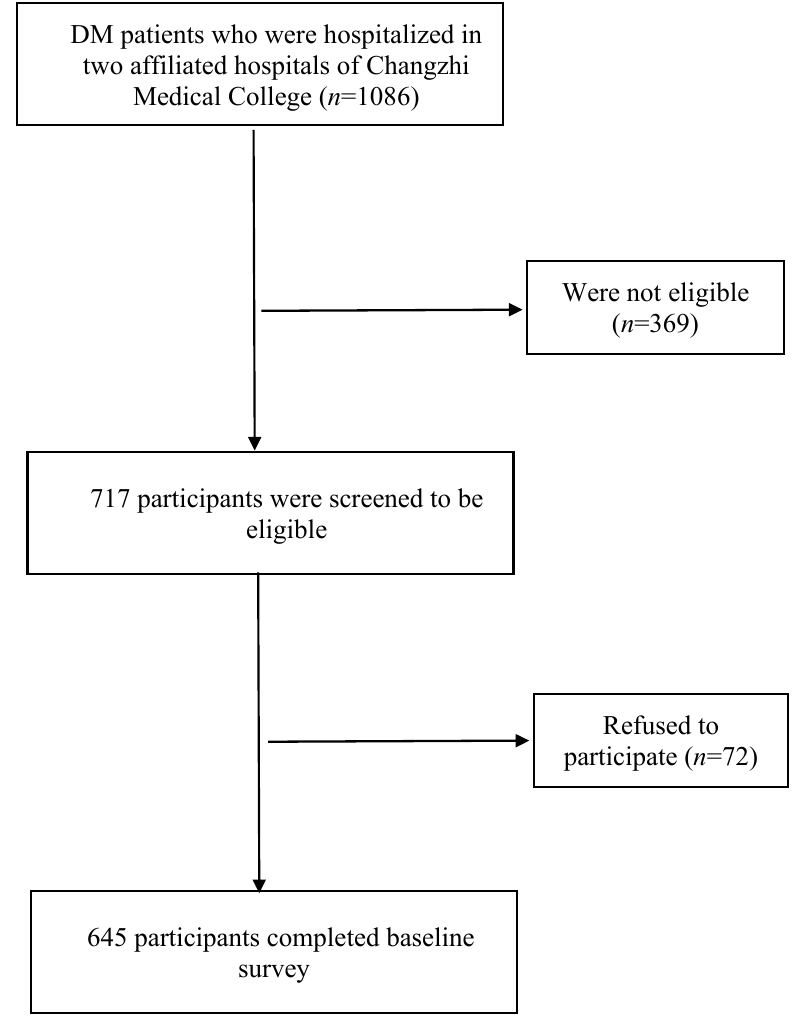
Figure 1. Flowchart of data